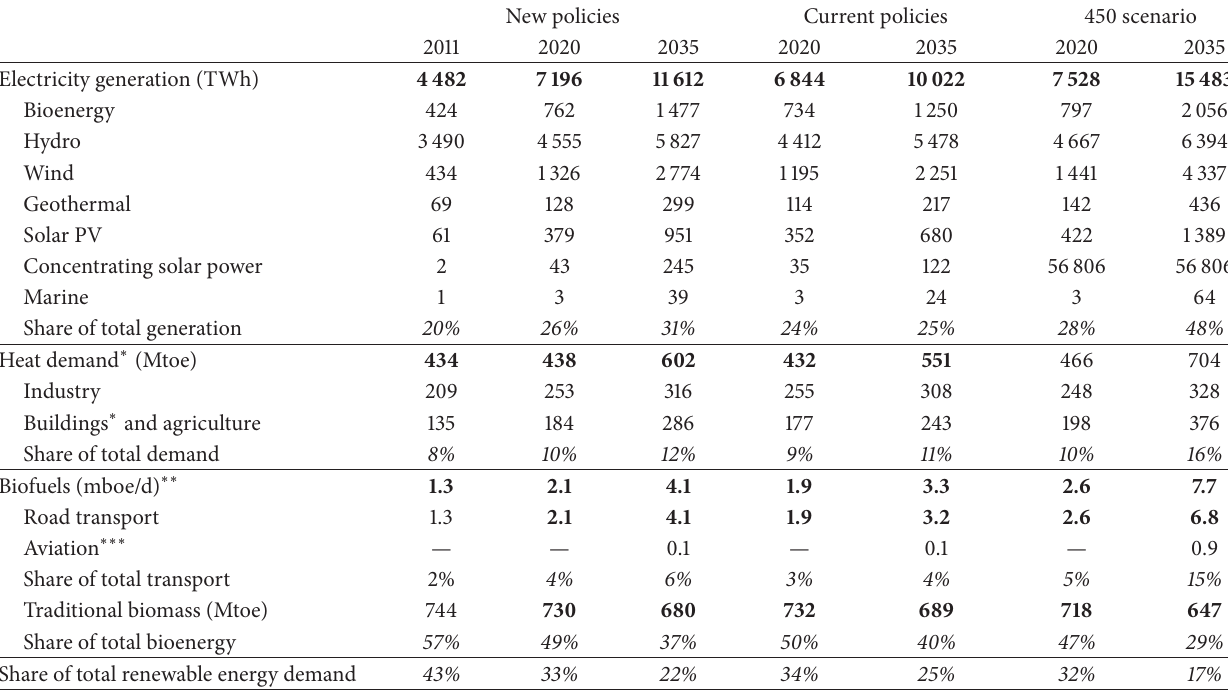
Table 4: World renewable energy use by type and scenario [85].